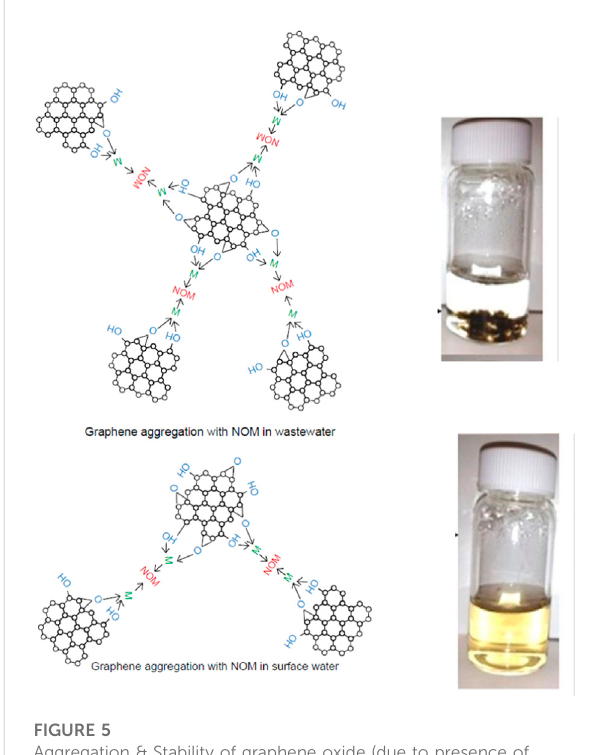
FIGURE 5 Aggregation & Stability of graphene oxide (due to presence of NOM and divalent cations (Ca 2+ , Mg 2+ ) in surface water and wastewater. Reprinted with permission from I. Chowdhury, M. C. Duch,N.D.Mansukhani,M.C.HersamandD.Bouchard,Environ. Sci. Technol., 2013, 47, 6288 – 6296. Copyright 2013, American Chemical Society (Chowdhury et al., 2013). Reprinted with